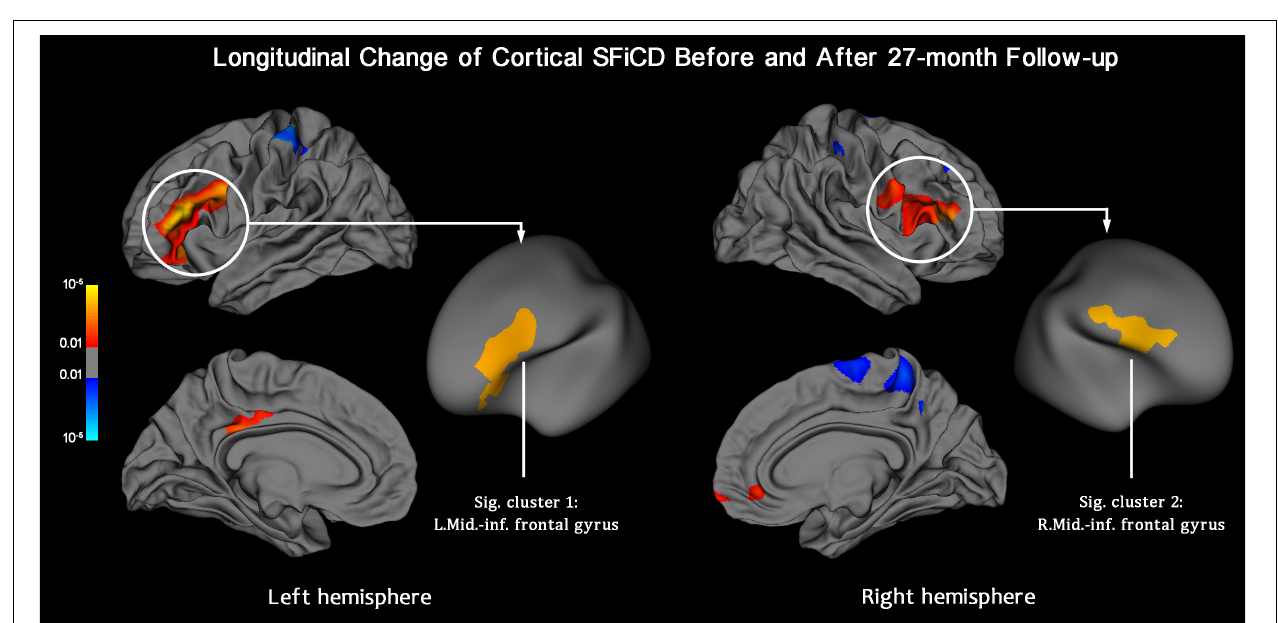
FIGURE 4 | Longitudinal change in the SFiCD after the 27-month follow-up period (within-group analysis). The statistical map is thresholded with a vertex-level P < 0.01. The clusters that survived Monte Carlo simulation correction (cluster-level P < 0.01) are further marked with circles. After 27 months, the cortical SFiCD was significantly increased in the bilateral middle-inferior frontal cortices (Sig. clusters 1 and 2).